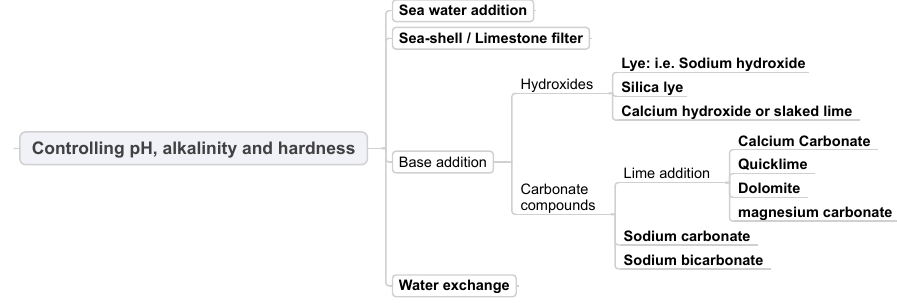
Figure 3. Taxonomy: controlling pH, alkalinity and